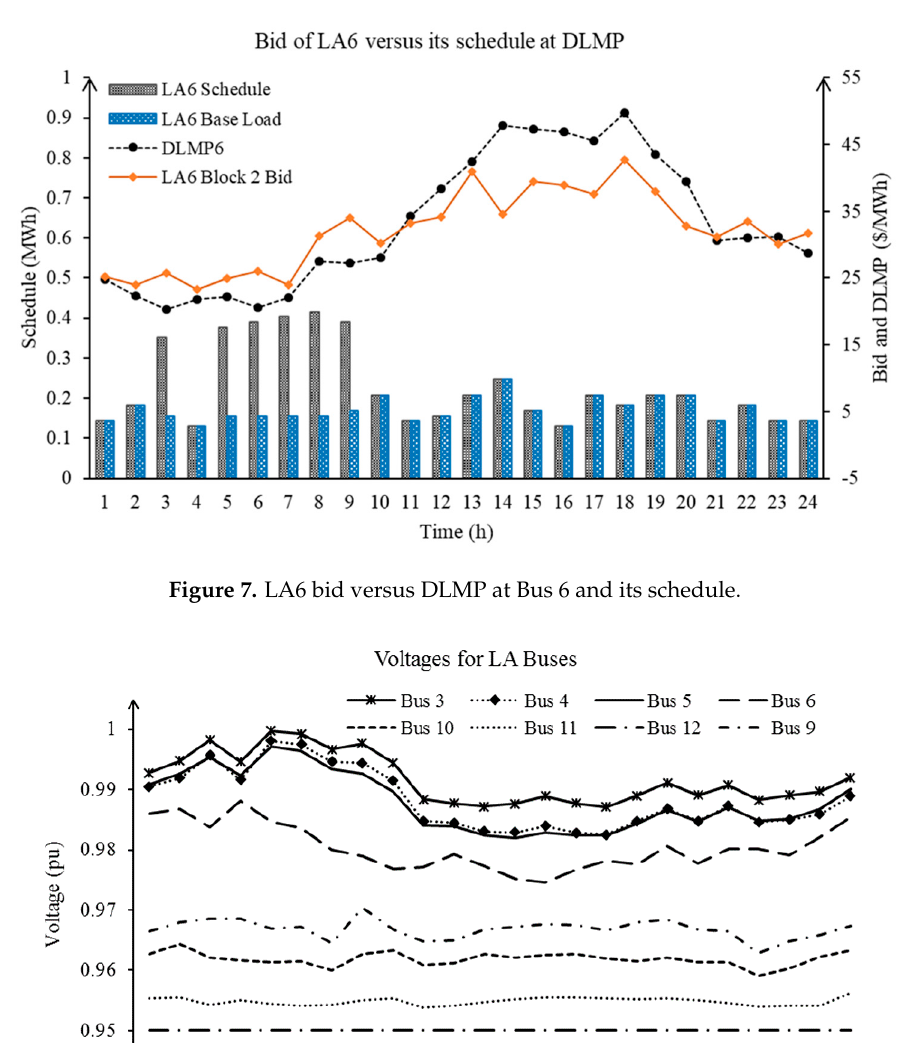
Figure 6. Wholesale injection at LMP versus DG7 and DG13’s schedules and DLMPs.